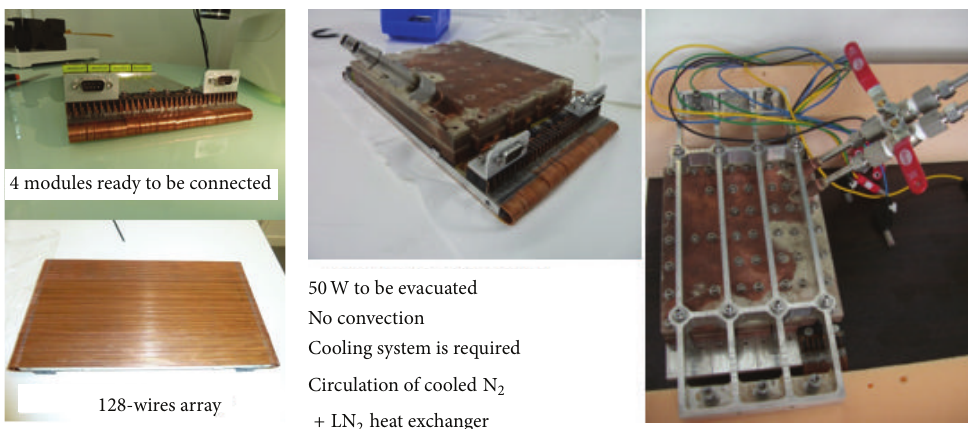
Figure 18: The magnetic excitation array is made of 4 modules of 32 wires each (1mm 2 ) constituting a 128-wire array. The wires are spaced by 0.25 mm.